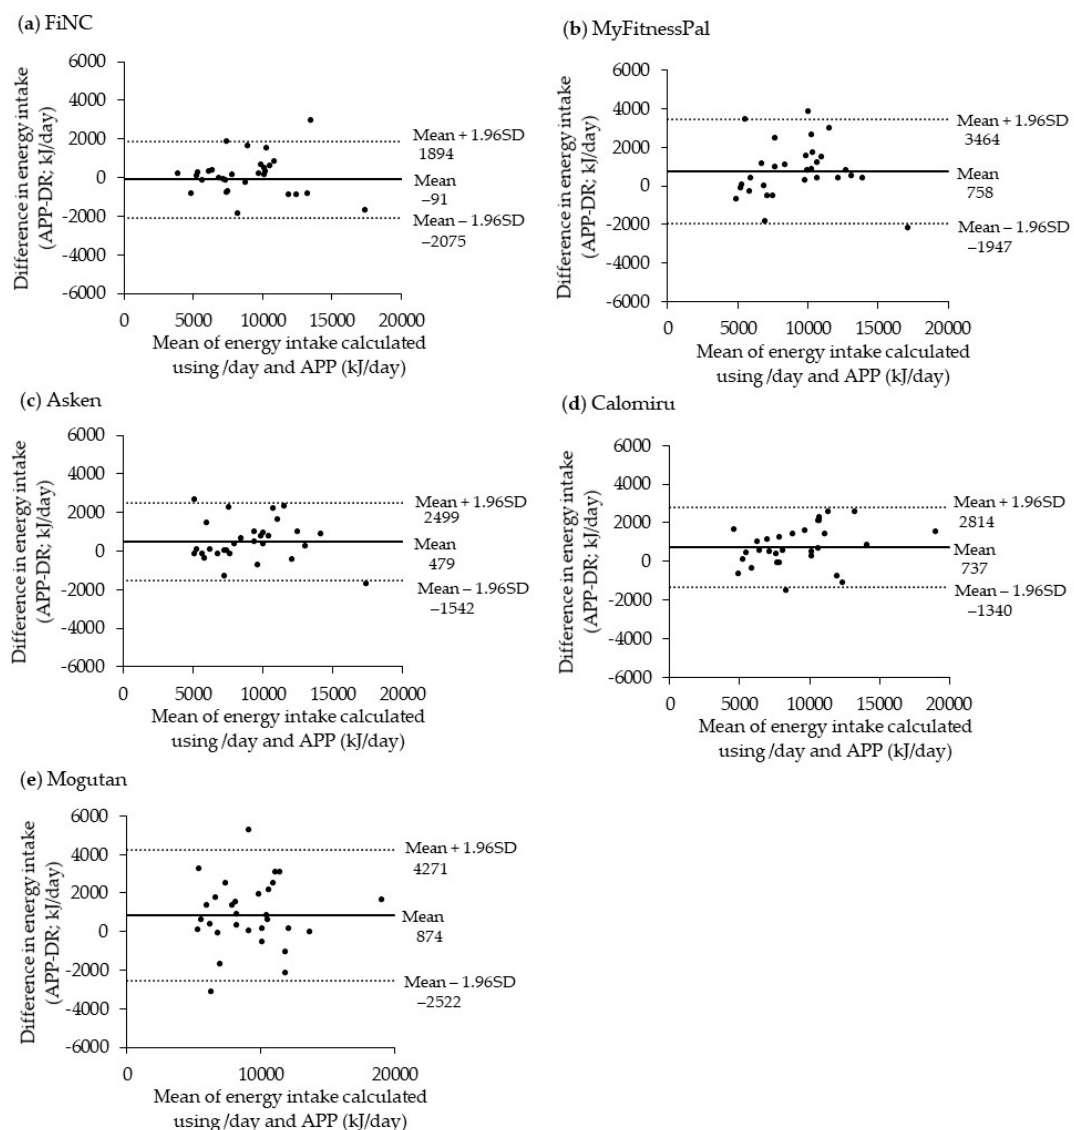
Figure 2. Bland–Altman plots assessing the agreement of the estimated energy intake between a paper-based dietary record (DR) and each application (APP) in 30 Japanese adults: ( a ) FiNC, ( b ) MyFitnessPal, ( c ) Asken, ( d ) Calomiru, and ( e ) Mogutan. The solid line represents the mean difference, and the dotted line represents lower and upper 95% limits of agreement. Table 3. Spearman correlation coefficients for the association between energy and nutrient intakes estimated by a one-day dietary record and those estimated by the five diet-tracking applications among Japanese adults ( n = 30) a .